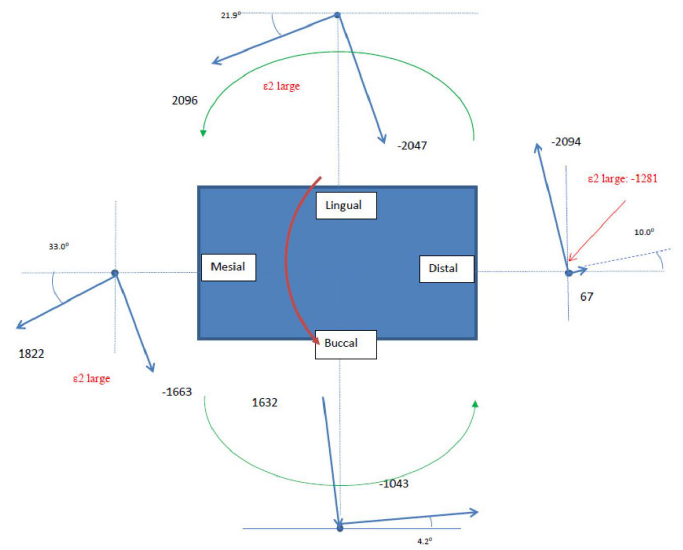
Figure 7. Principal strains and their orientations (not drawn to scale): where, indicated in red, the value of ε 2 was of a relatively large magnitude, and this has been included to be indicative of a high torsional element. The green circular arrows represent the overall “horizontal” torsional (rotatory) effect on the RBI. Horizontally: the mesial and distal gauges now combined to show an overall counter-clockwise torsion (green arrows). Vertically: there was a strong push to the buccal: the overall trend was a buccally oriented torsion (red